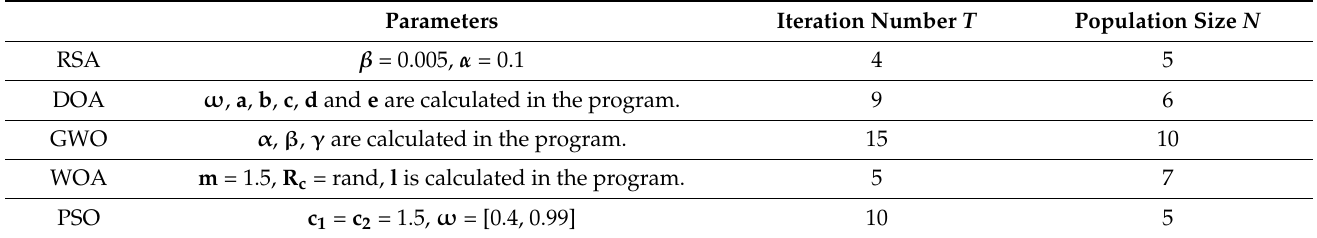
Table 1. Setting of optimization algorithms’ parameters.